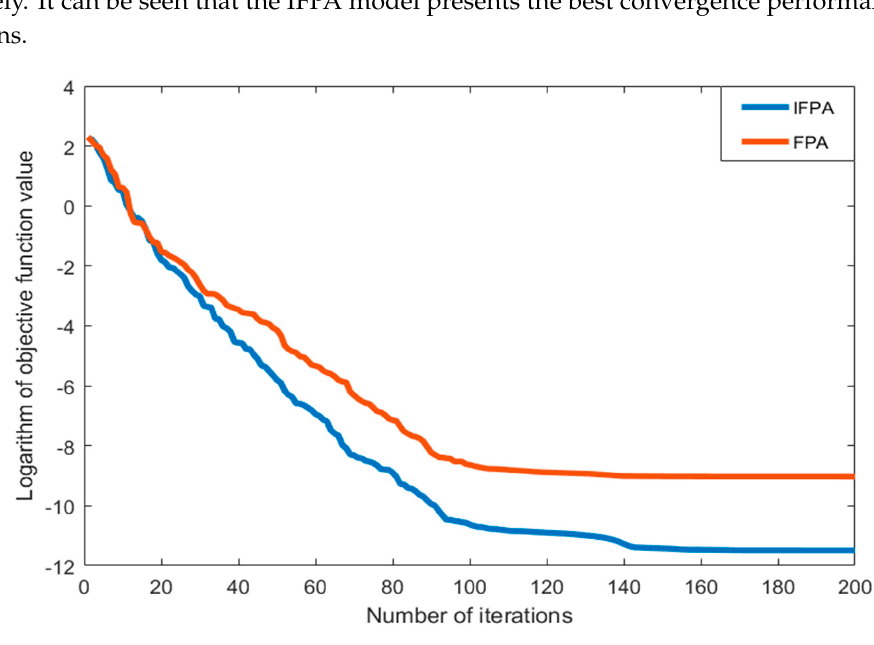
Figure 5. Iterative convergence curve from the Schaffer function.